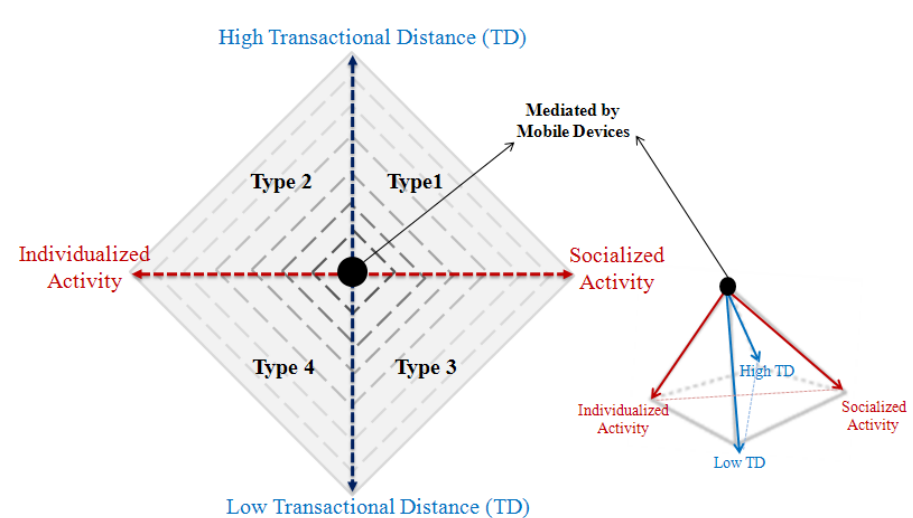
Figure 3 . Four types of mobile learning: A pedagogical